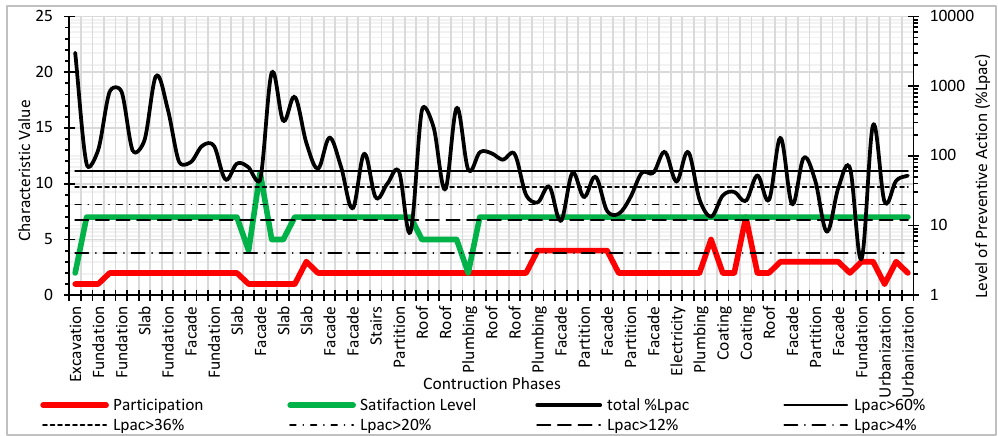
Figure 14. Level of Preventive Action and Parameters of Participation and satisfaction of workers.